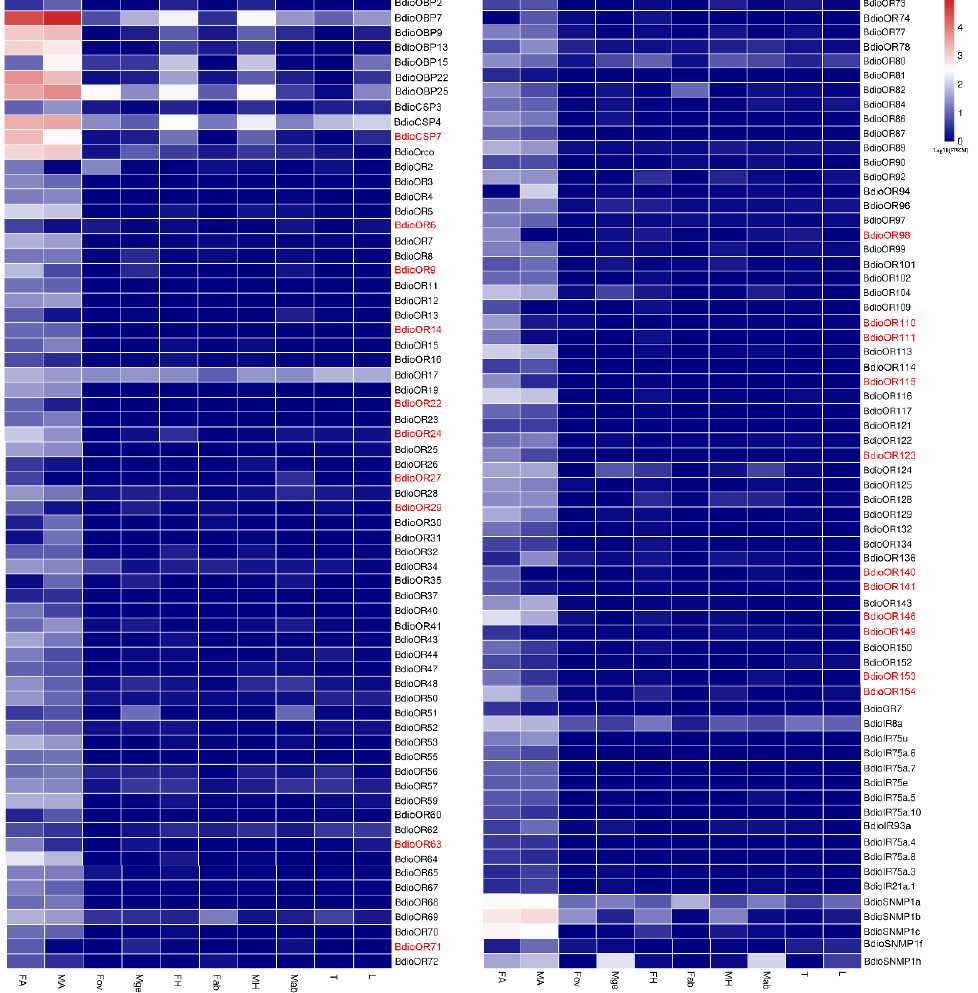
Figure 9. Expression profiles of antennae-biased chemosensory genes in B. dioryctriae. The chemosensory genes with female antennae-biased expression are marked in red, with a standard of q value < 0.005 &|log2 (fold change) > 2 when FA vs. MA. FA and MA: female and male antennae; FH and MH: female and male heads without antennae; Fab: female abdomens without ovipositors and digestive tracts; Fov: female ovipositors; Mge: male genitalia; Mab: male abdomens without genitalia and digestive tracts; T: male and female thoraxes; L: male and female legs.